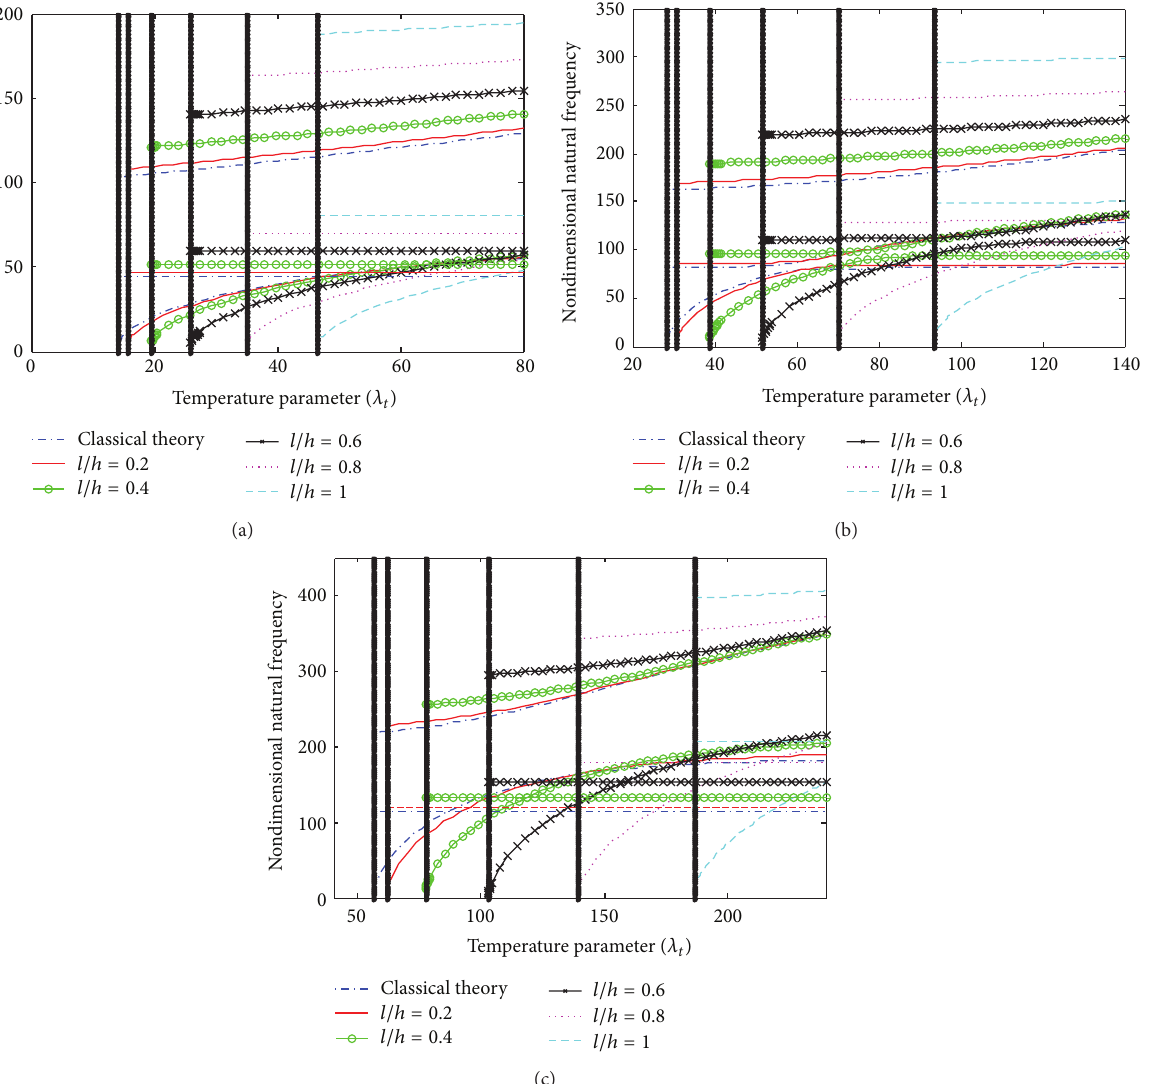
Figure 11: Variation of the nondimensional natural frequency of vibration around the (a) first, (b) second, (c) third buckling mode with the temperature parameter for a clamped-clamped FG beam with different values of 𝑙/ℎ ( 𝑘 = 1 , 𝐿/ℎ = 40